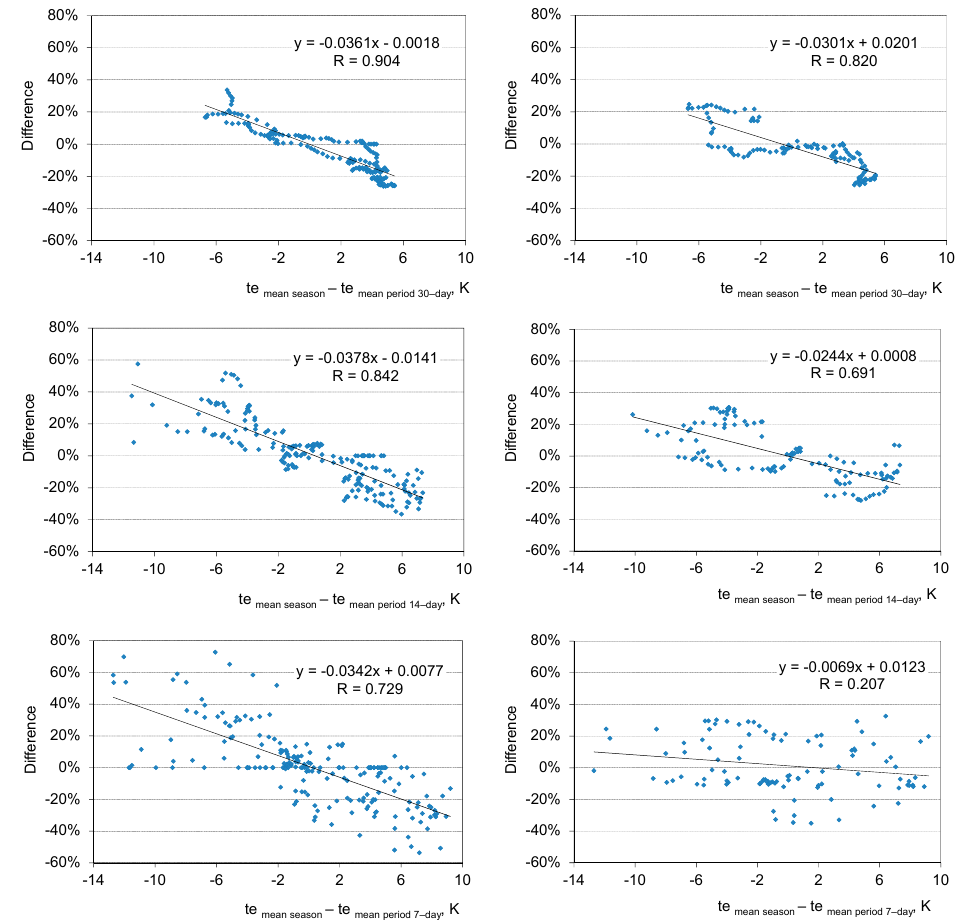
Figure 7. Correlation between the seasonal heat demand difference and external temperature difference (mean for the season and mean for each short period) for the residential building (on the left) and for the school building (on the right); only for periods with R ≥ 0.6, see Figure 6.